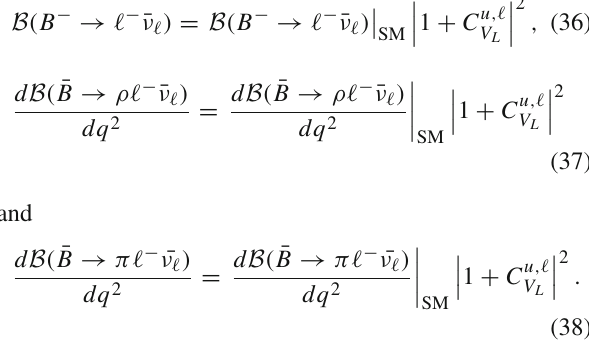
,μ and C u ,τ under different assumptions about the relation between C u , e P P